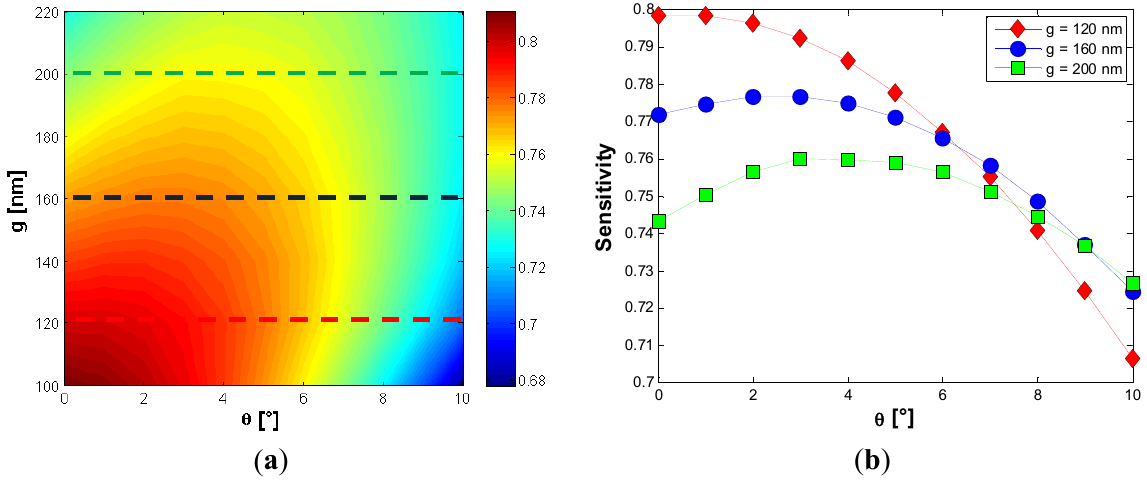
Figure 6. ( a ) Calculated Sensitivity versus g and ϑ , with W = 220 nm and H = 220 nm; ( b ) Sensitivity versus ϑ for different values of g